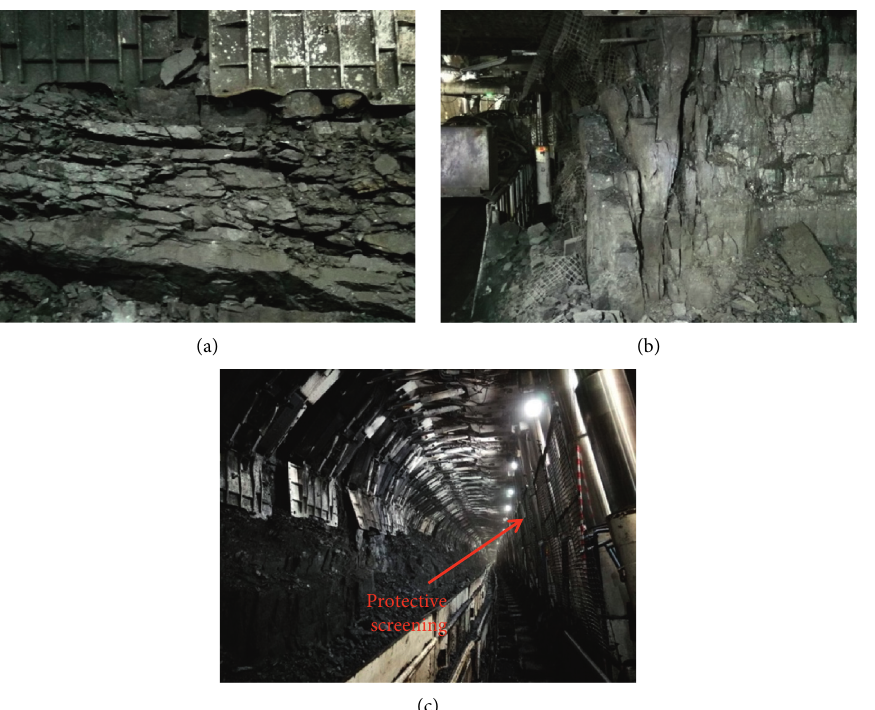
Figure 1: Examples of failure modes along the 12401 working face coal wall. (a) Horizontal crack. (b) Longitudinal crack. (c) Protective screening.